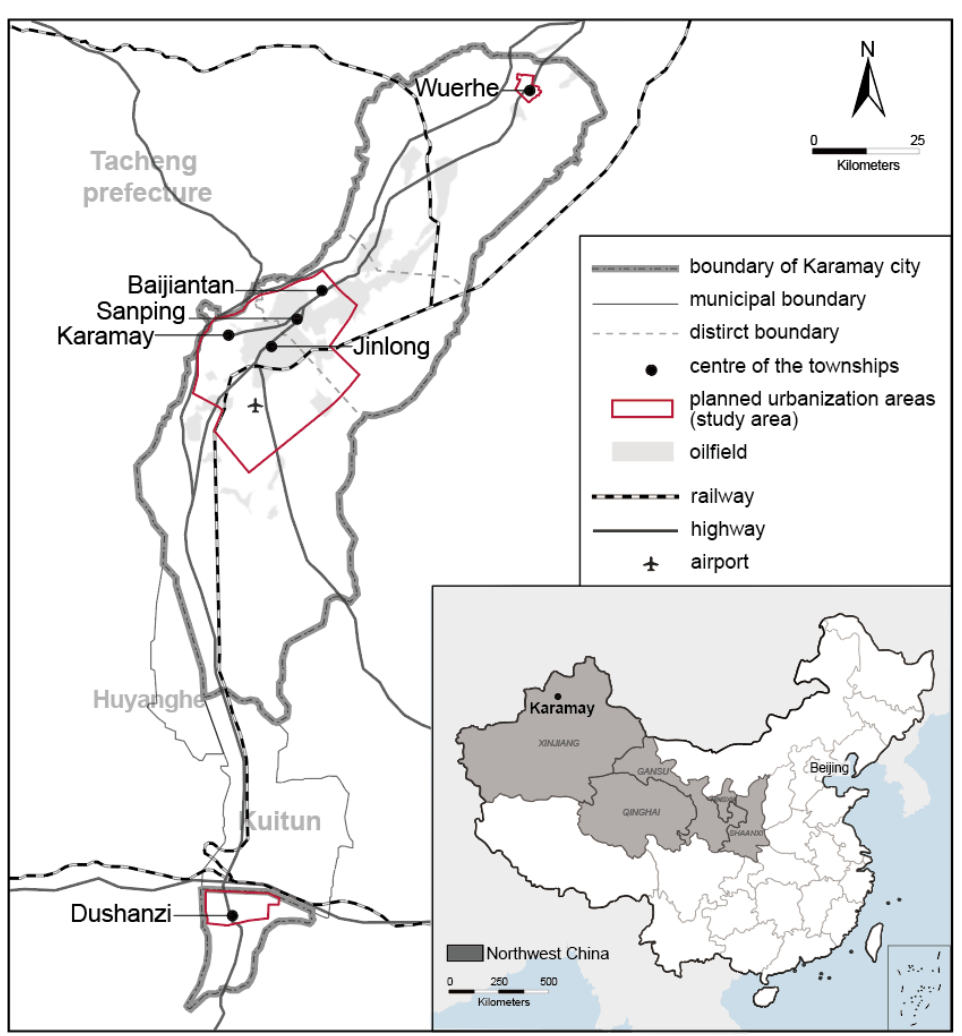
Figure 1. Map showing Northwest China, as well as the location and spatial organization of Karamay city and the study area. Table 1. Basic information about study areas.